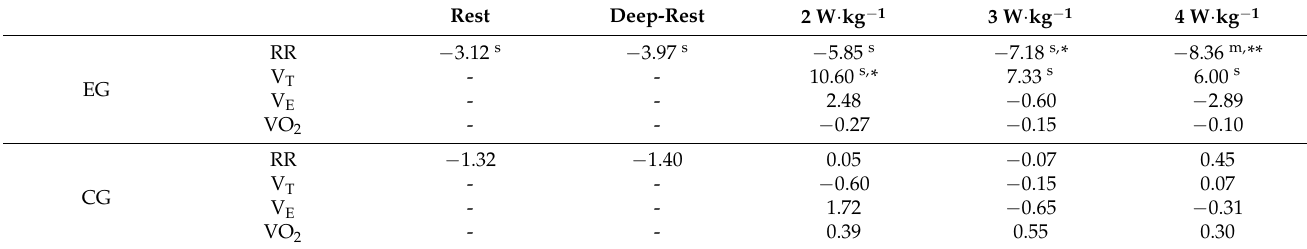
Table 2. Percent change in respiratory rate (RR), tidal volume (V T ), minute ventilatory volume (V E ) and oxygen consumption (VO 2 ) after breathing exercises intervention versus exercise prior to breathing exercises intervention at different intensities in the experimental group (EG) and control group